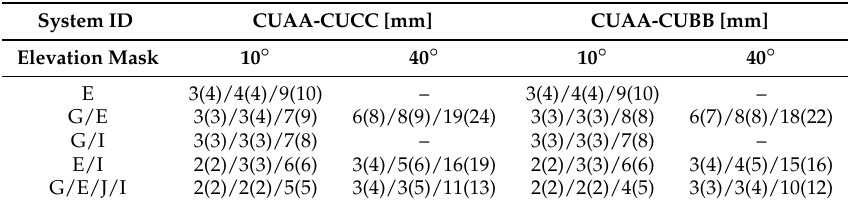
Table 4. Empirical and average formal (in brackets) standard deviations of the ambiguity-fixed baseline errors. The results are given in the north/east/height directions. The data on DOY 224, 2018 was used for both